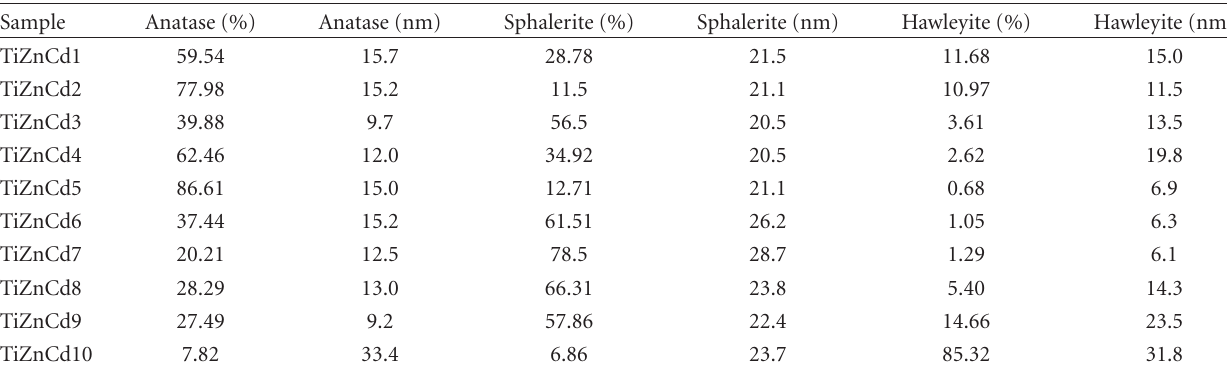
Table 2: Phase composition and crystallite size of nanocomposites TiO 2